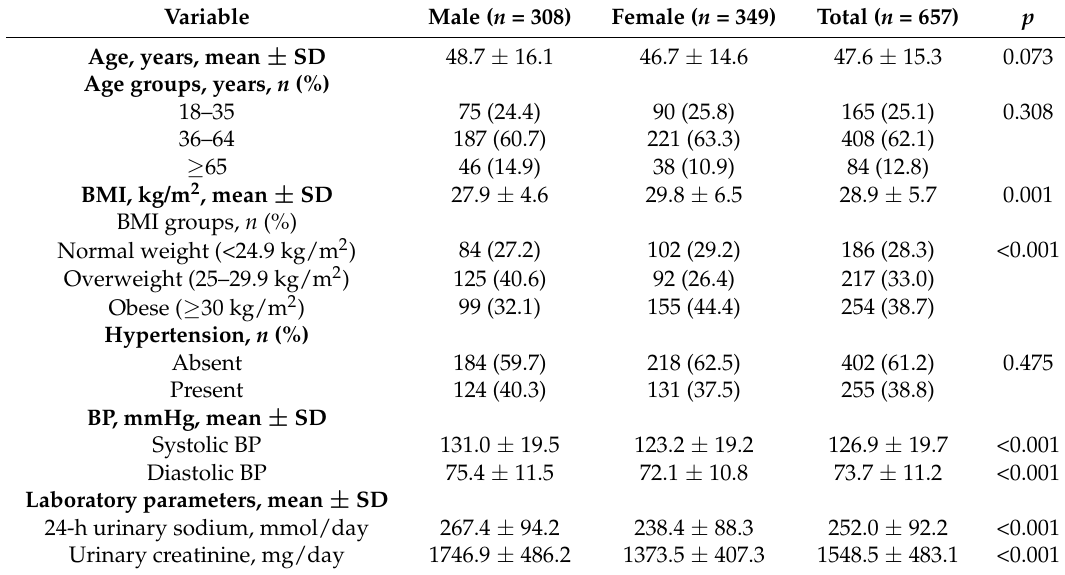
Table 1. Demographic and clinical characteristics of the 657 participants with accurate 24 h urine samples.